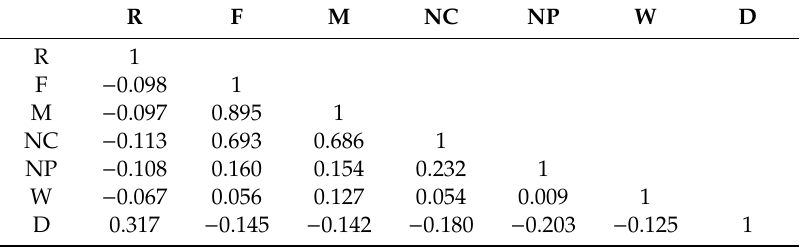
Table 5. Statistical correlation between recency (R), frequency (F), monetary (M), number of